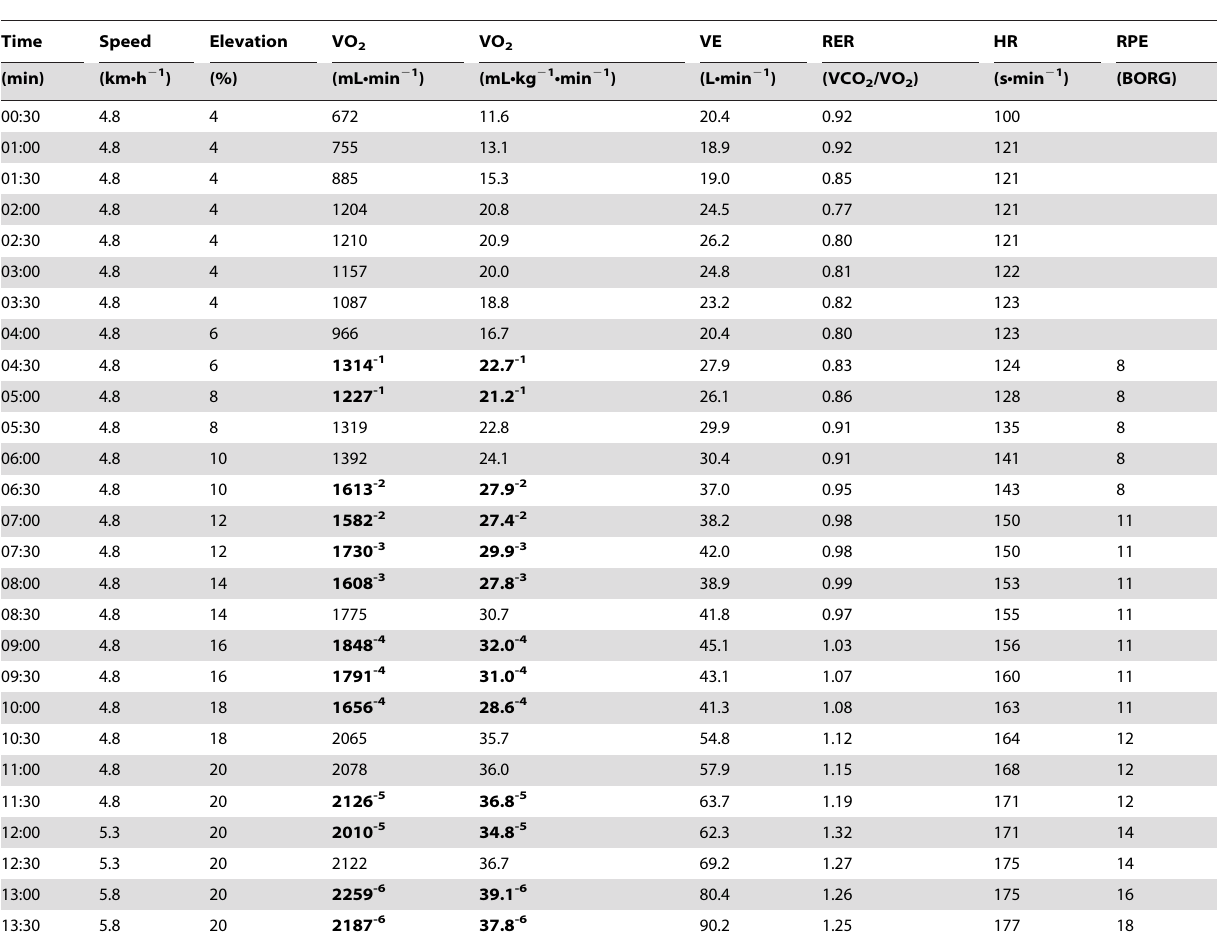
Table 3. Raw data from baseline to limit of tolerance during a maximal progressive graded exercise